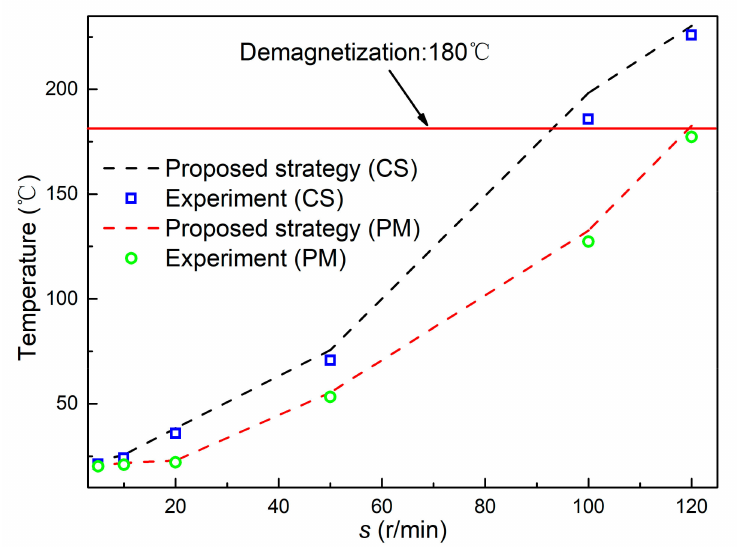
Figure 17. Comparison between the proposed strategy and experiment ( l g = 5 mm).